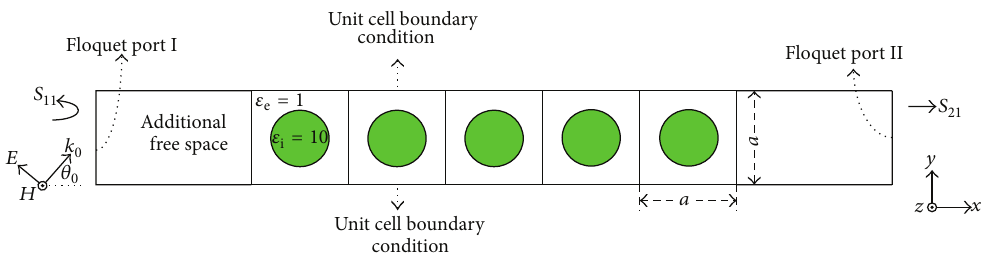
Figure 1: The quasi-2D geometry of the dielectric slab constructed in CST MWS, where the slab thickness in the 𝑧 -direction is 𝑎 /100 to reduce the computational complexity, and the unit cell boundary condition is assigned to the 𝑦 - and 𝑧 -bounds. The environment and inclusion permittivities are denoted as 𝜀 𝑒 and 𝜀 𝑖 , while 𝜃 0 is the incidence angle of the TM 𝑥𝑦 -polarized plane